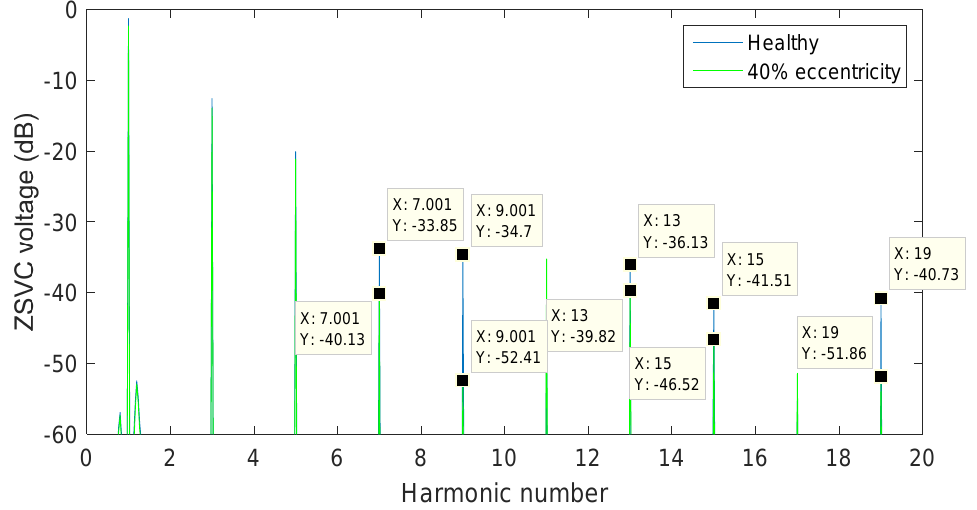
Figure 6. Rated operating conditions. Spectral content of the ZSVC. Healthy machine and faulty machine with 40% eccentricity.